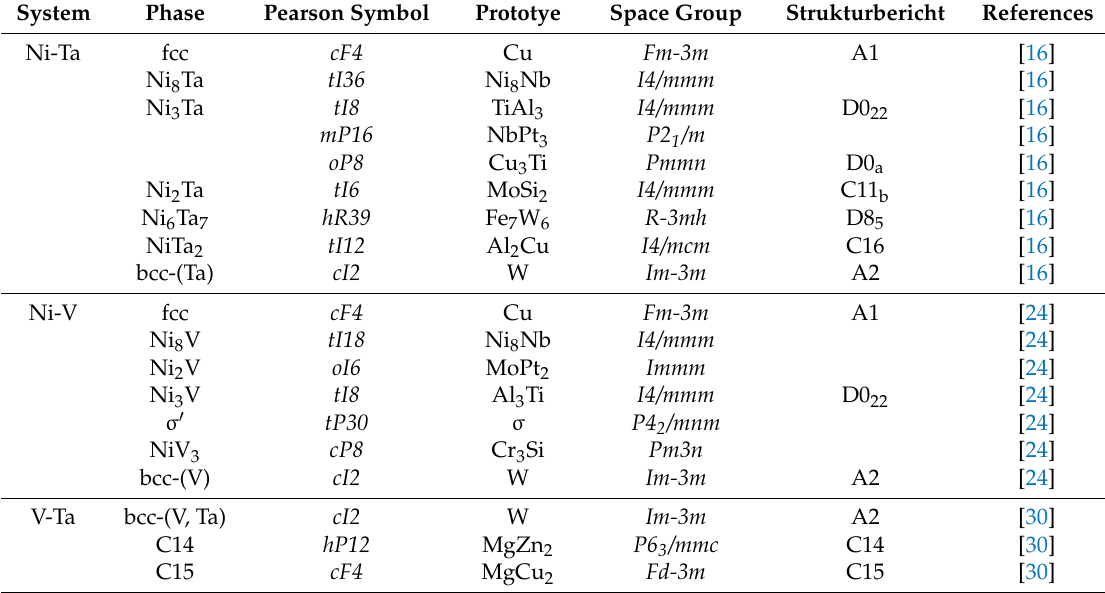
Table 1. The stable solid phases in the three binary systems. Data from [16,24,30].